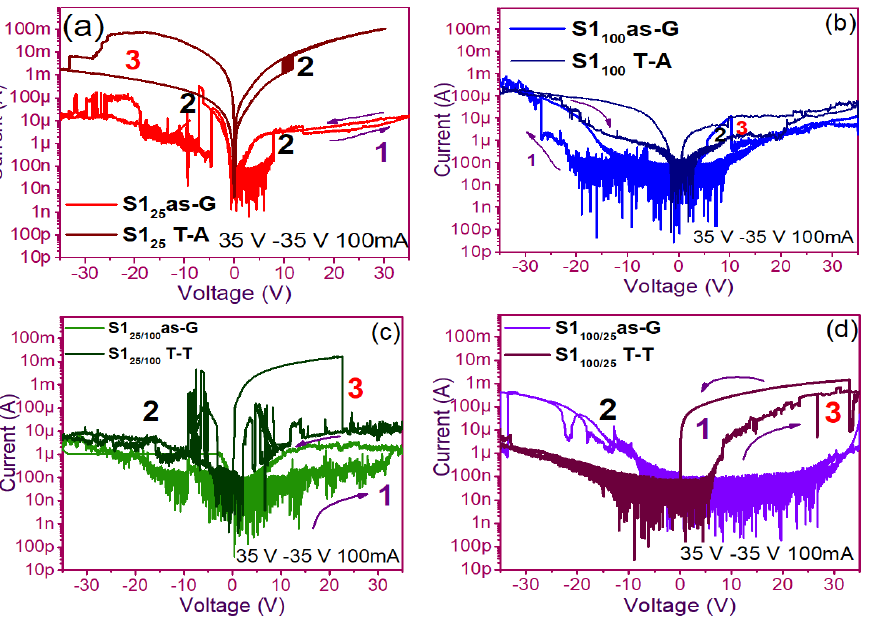
Figure 3. Pristine I-V curves ( a ) S1 25 as-G and T-A, ( b ) S1 100 as-G and T-A, ( c ) S1 25/100 as-G and T-A, ( d ) S1 100/25 as-G and T-A.